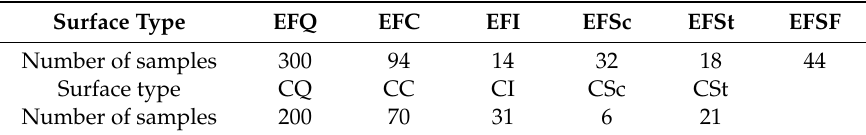
Table 1. Distribution of different categories of initial roller dataset.